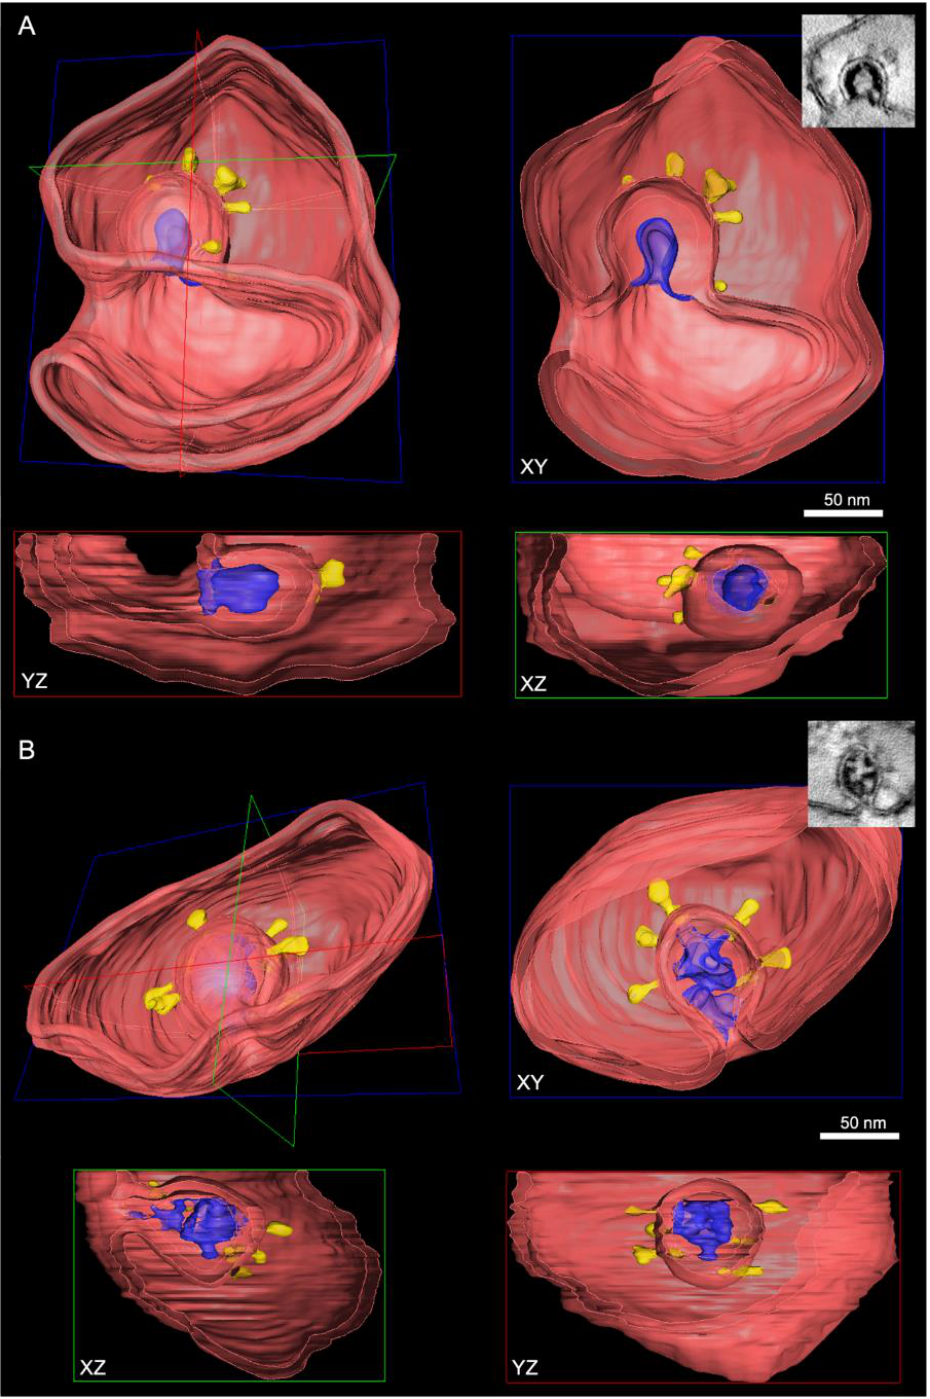
Figure 5. SARS-CoV-2 virion assembly in 3D. The cross-sectioned SMVs are shown in the respective XY, YZ and XZ perspectives. ( A ) Membrane profile at the “Omega stage” of virion assembly (from Figure 4B(III)). The virion shown here assembles at an invagination of the SMV membrane. ( B ) Virion that is still in contact with the cytoplasm by a narrow bud neck (from Figure 4B(IV)). Red: SMV membrane; blue: nucleocapsid; yellow: S protein associated with the forming virion envelope. The vRNP inside virions was visible as individual black dots, similar as in cryo-EM data [20,22,26], covering the entire inner leaflet of the forming virion envelope at all stages